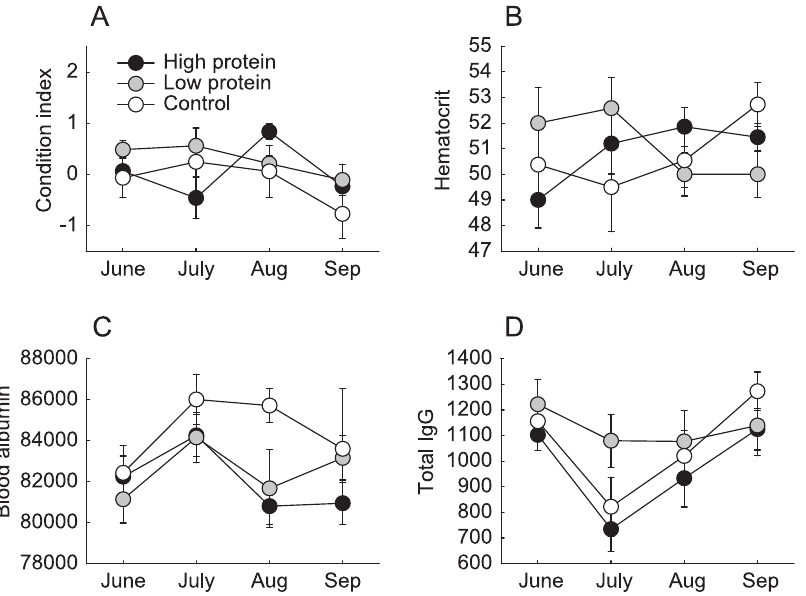
Figure 4. Condition indices of male voles from experimental populations (mean ± se). (A) body condition index, (B) haematocrit, (C) plasma albumin, (D) total IgG antibody titer.